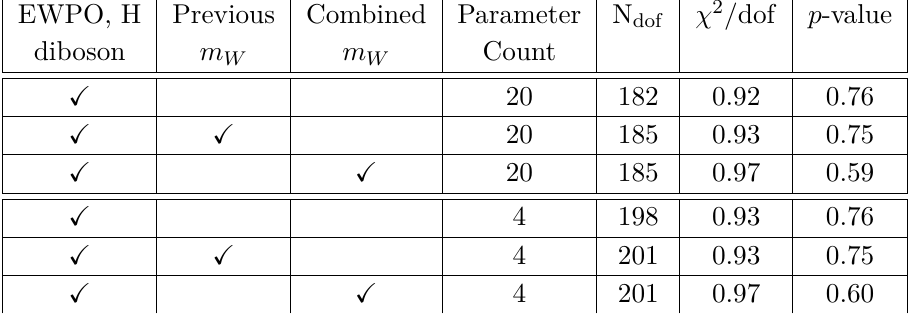
Table 6 . Fits to the electroweak, Higgs and diboson data either without any m W measurement, or with the measurements prior to the recent CDF measurement, or with the combination of the CDF and previous measurements, using either the full set of 20 SMEFT operators or only the 4 operators that can increase m W relative to its SM